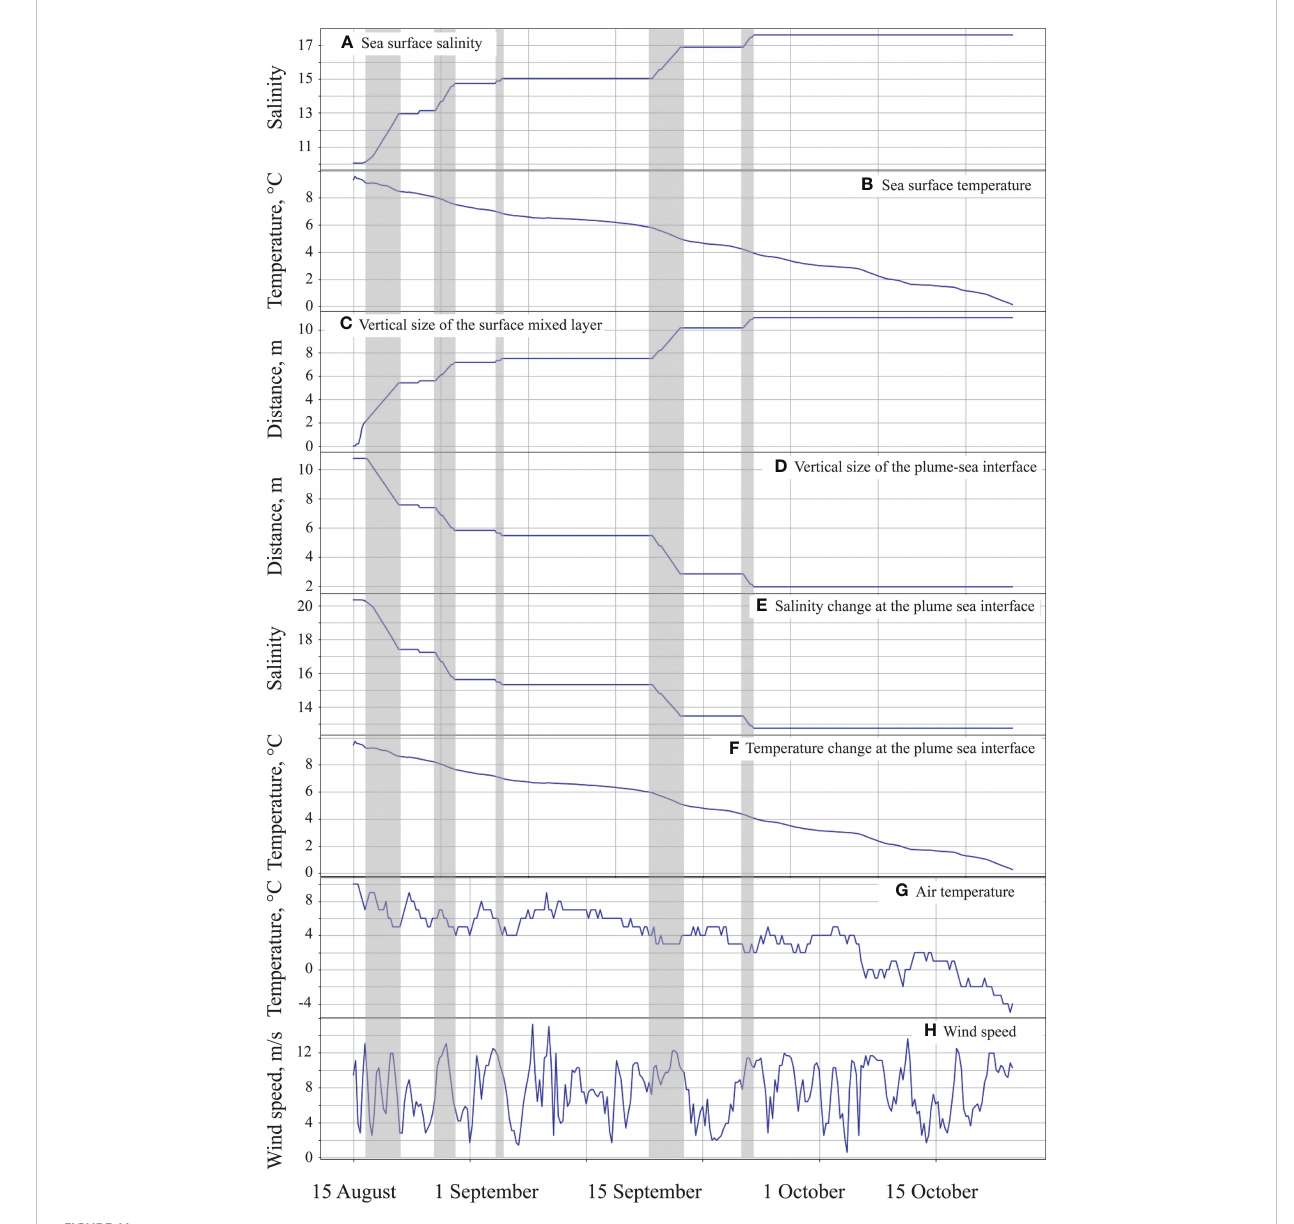
FIGURE 11 Surface salinity (A) and temperature (B) , vertical sizes of the surface mixed layer (C) and the plume-sea interface (D) , temperature (E) and salinity (F) changes at plume-sea interface, air temperature (G) and wind speed (H) during the period of numerical modeling of vertical structure of the central part of the Ob-Yenisei plume from the middle of August till late October. Gray bands indicate periods of intense